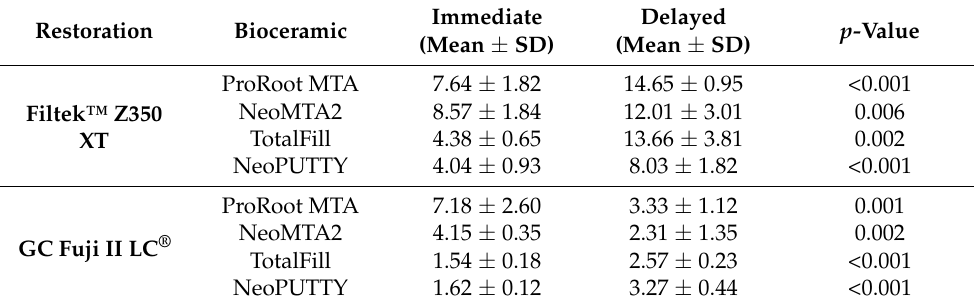
Table 4. Comparison of mean ± standard deviation (SD) of immediate vs. delayed restoration with bioceramic